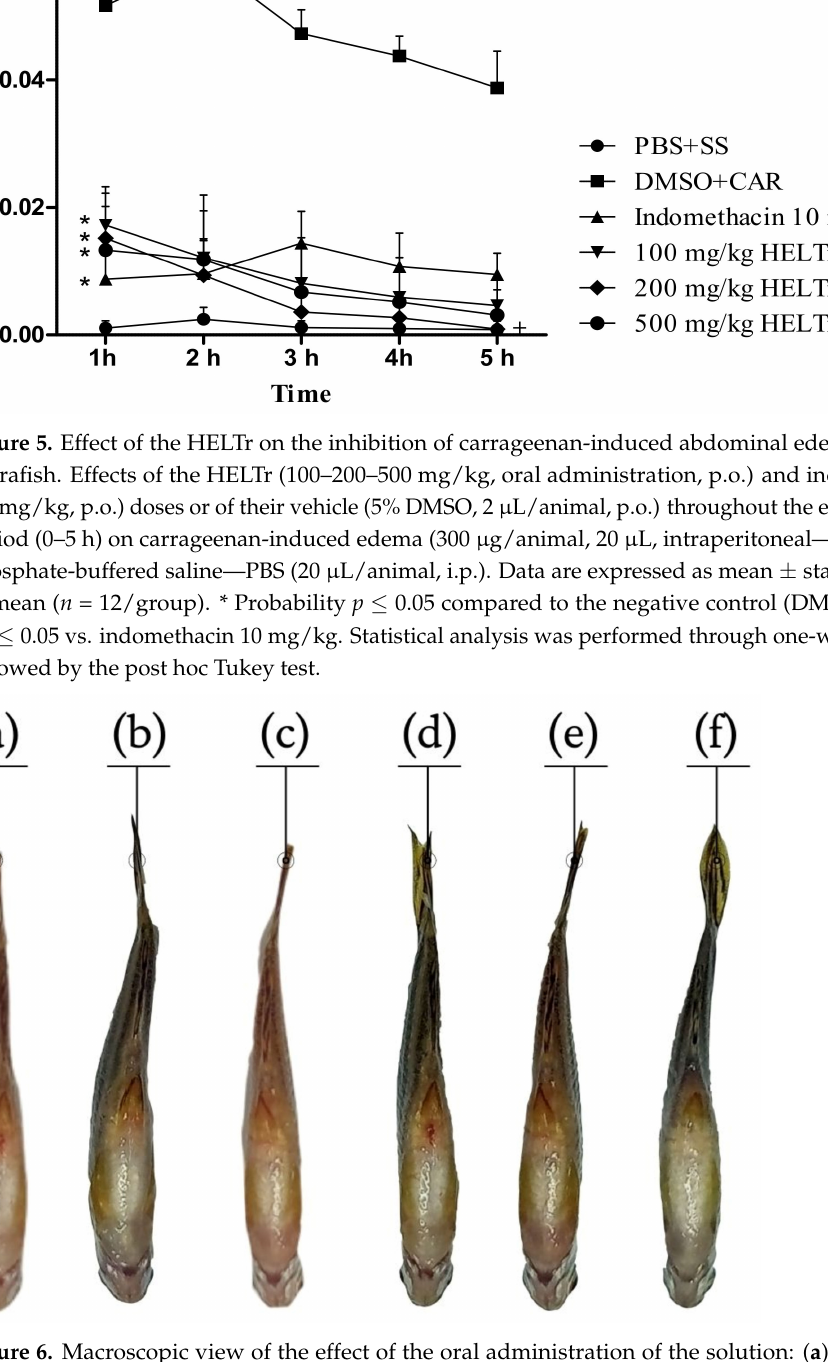
Figure 6. Macroscopic view of the effect of the oral administration of the solution: ( a ) PBS—2 µ L; ( b ) carrageenan—200 µ g/anima; ( c ) indomethacin—10 mg/kg); ( d ), ( e ) and ( f ) HELTr—100, 200 and 500 mg/kg,